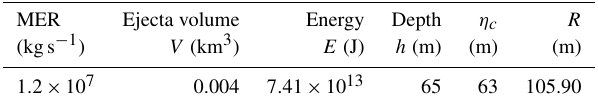
Table 3. Numerical values used in Lake Taup¯o